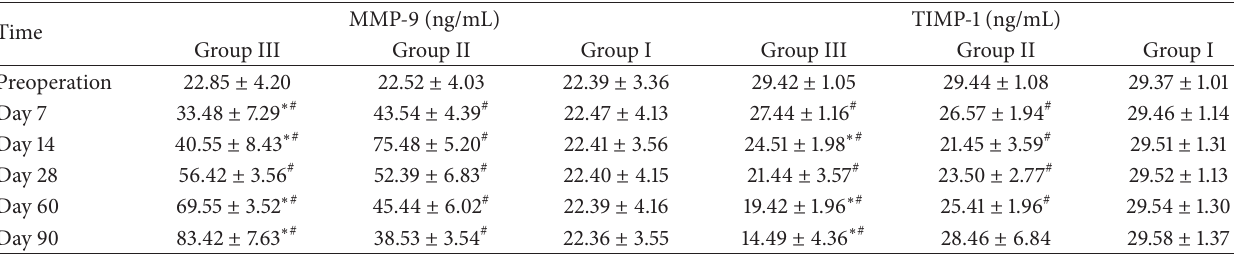
Table 1: Dynamic expressions of MMP-9 and TIMP-1 in aqueous humor of alkali-burned rabbit cornea following Boston Type 1 keratoprosthesis (KPro)